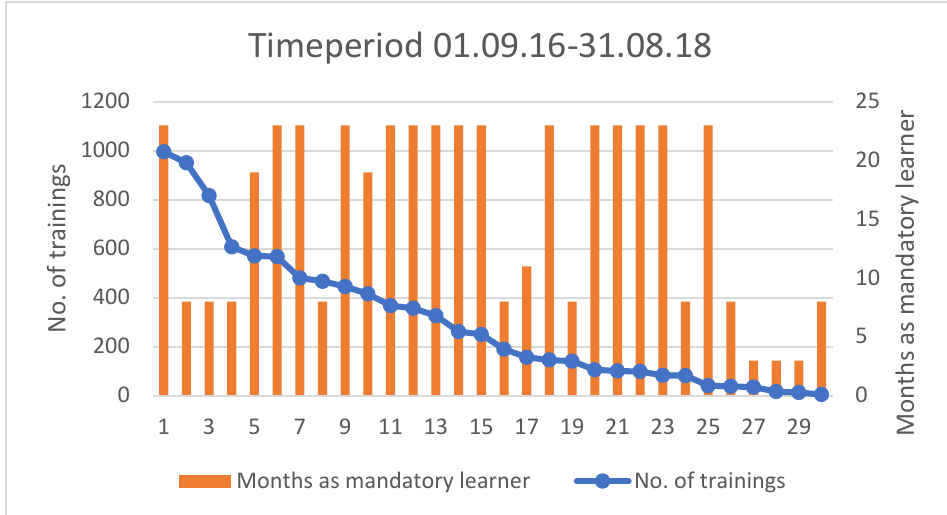
Figure 3. Descriptive data of training frequency for each midwife and duration of time classified as mandatory learner. The X ‐ axis shows the individual midwives participating in the study, numbered from 1–30. The left Y ‐ axis shows the number of trainings per midwife during their period as mandatory learner, illustrated by the blue frequency line. The midwifes are sorted according to this frequency.